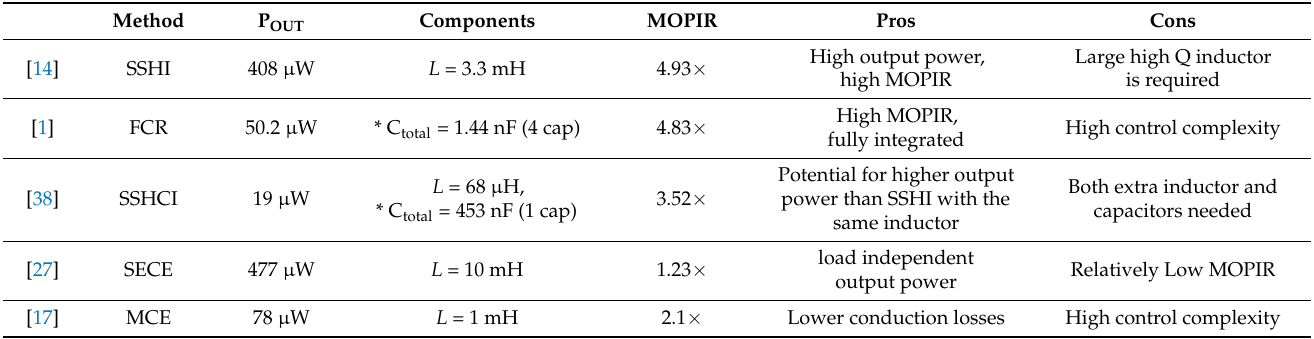
Table 3. Comparison for the non-linear methods based on the SECE and the